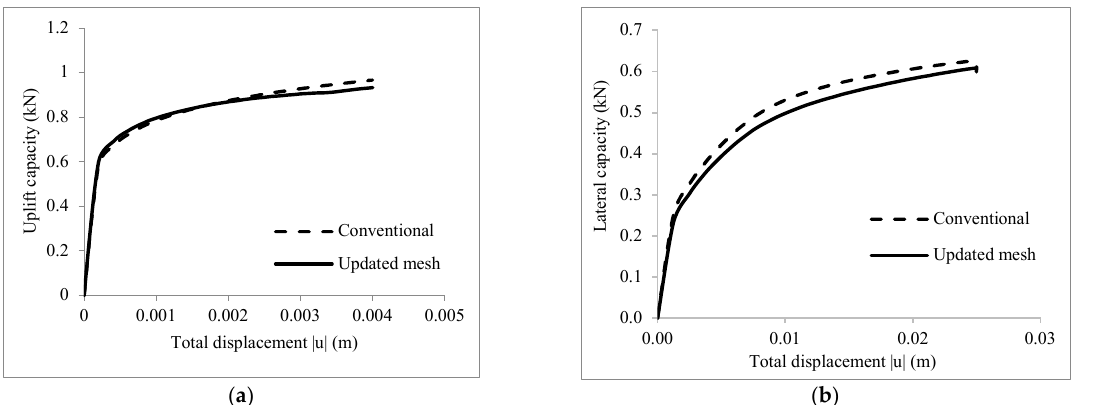
Figure 5. Conventional analysis (Eulerian) vs. Update mesh analysis (Lagrangian) under ( a ) Uplift loading; and ( b ) Lateral loading.